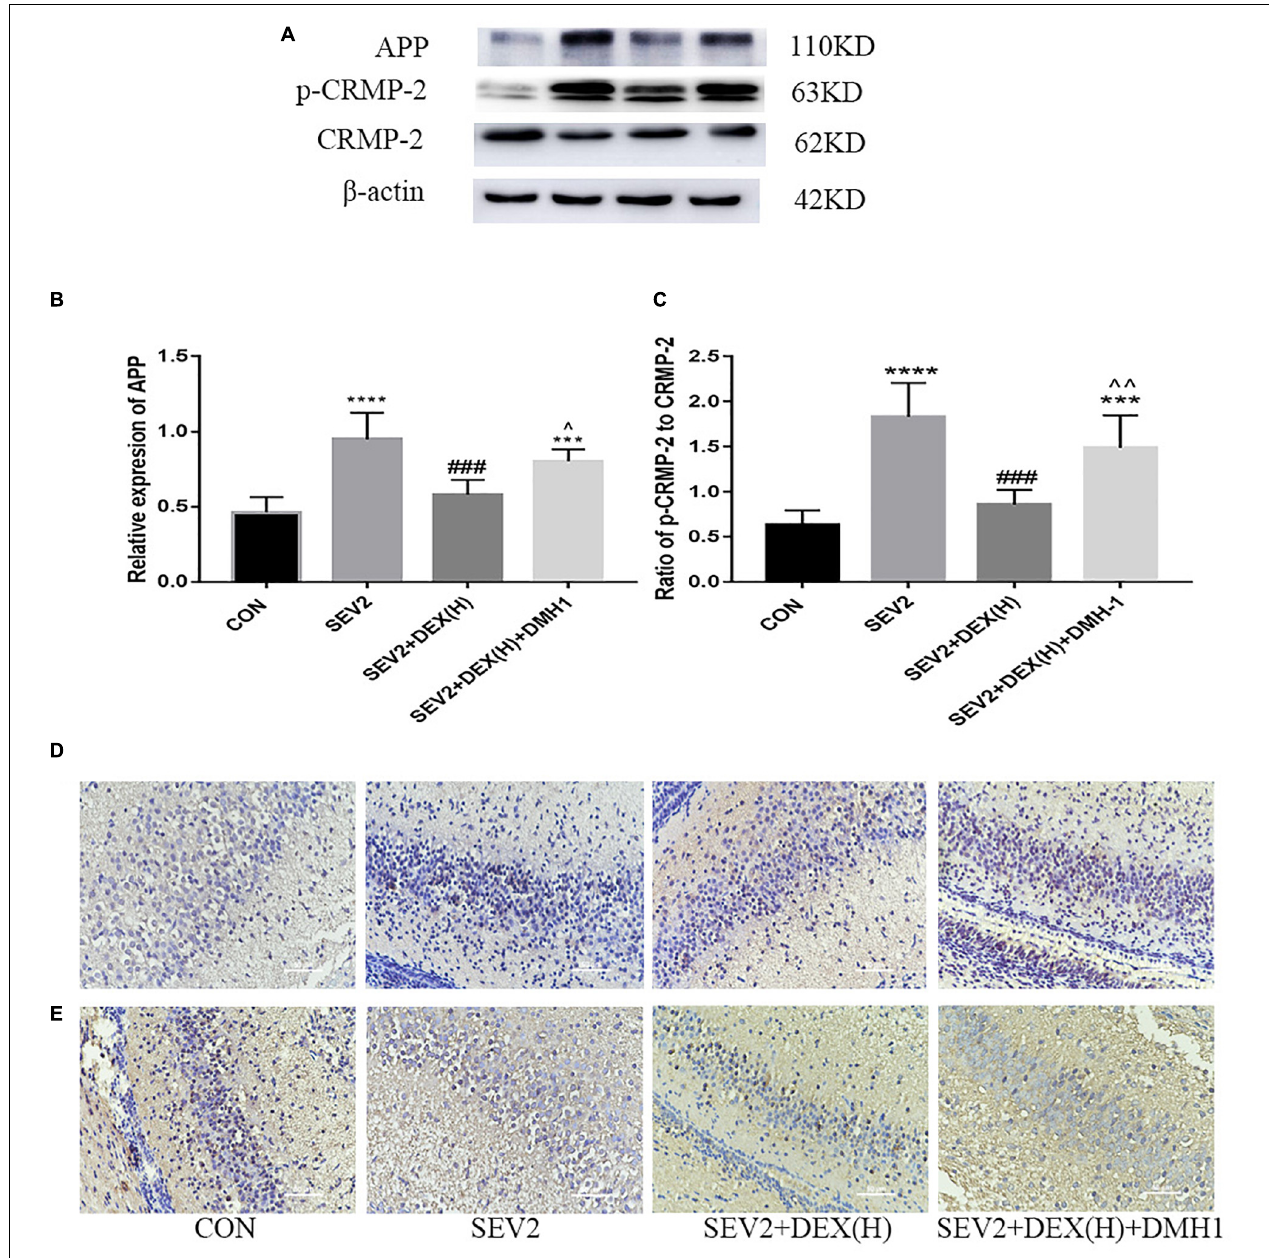
FIGURE 7 | Neuroprotective effect of Dex against sevoflurane-induced axonal injury could be inhibited by DMH1. Representative Western blots for the expression levels of APP, p-CRMP-2, and CRMP-2 (A) at P1. Quantification of APP (B) normalized to β -actin and p-CRMP-2/CRMP-2 (C) . Data are expressed as means ± SEM ( n = 6 in each group). Comparisons were made using one-way ANOVA and post hoc Tukey’s correction. ∗∗∗ P < 0.001, ∗∗∗∗ P < 0.0001 compared to the CON group; ### P < 0.001 compared to the SEV2 group; ∧ P < 0.05, ∧∧ P < 0.01, compared to the SEV2+DEX(H) group. The expression of APP (D) and CRMP-2 (E) in hippocampal CA1 region in the IHC assay. Scale bar = 50 µ